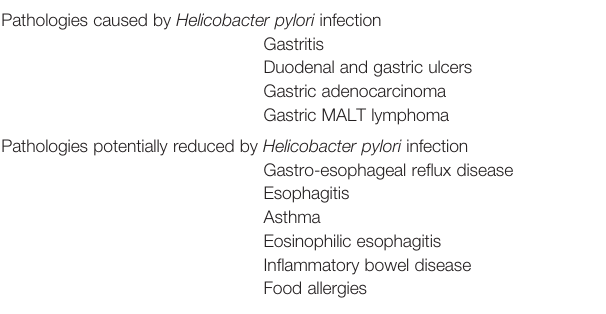
TABLE 1 | Helicobacterpylori infection promotes or reduces human pathologies. Pathologies caused by Helicobacter pylori infection Gastritis Duodenal and gastric ulcers Gastric adenocarcinoma